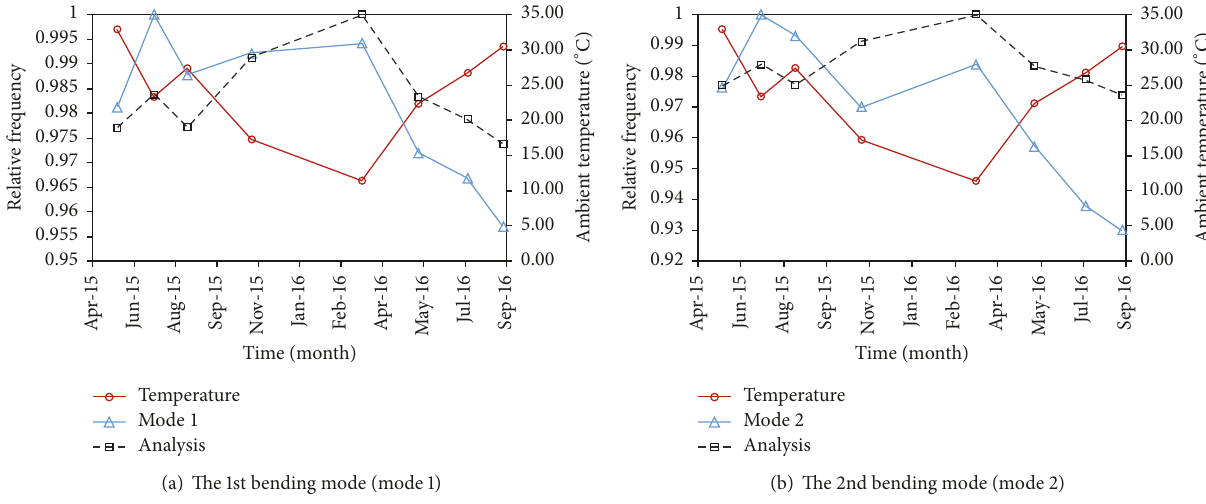
Figure 26: ((a)-(b)) Variations in two bending modal frequencies of girder No. 2 over one and a half years.